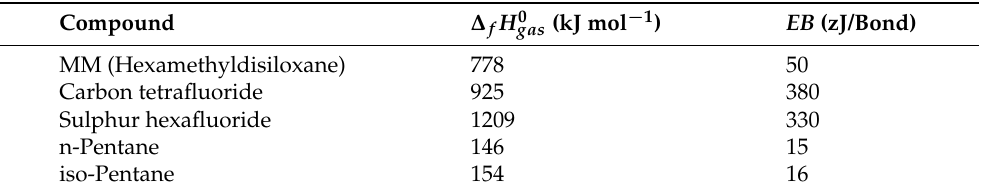
Table 1. Standard formation enthalpies ∆ f H 0 gas at 25°C and the estimated mean energy bond EB for the atoms in the molecule for some compounds. The values of ∆ f H 0 gas are from [29].